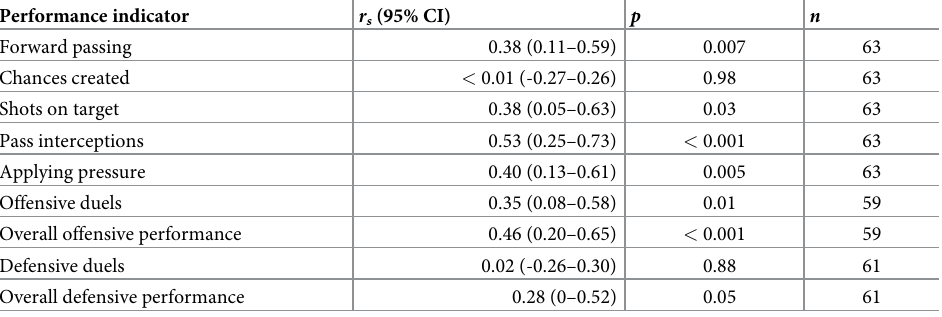
Table 4. Aggregated Spearman’s correlations between the performance indicators in the SSGs and 11-vs-11 games.